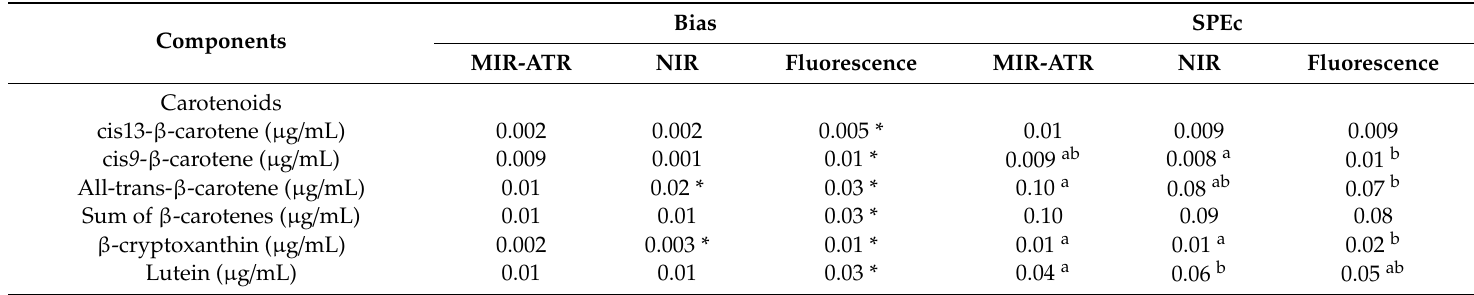
Table 6. Bias and standard error of prediction corrected for bias (SEPc) for milk carotenoids, vitamins and selected fatty acids (FA, expressed in g 100 / g of the total FA) obtained when each sample of validation set was predicted using calibration equation selected according to the spectroscopy technique: mid-infrared using